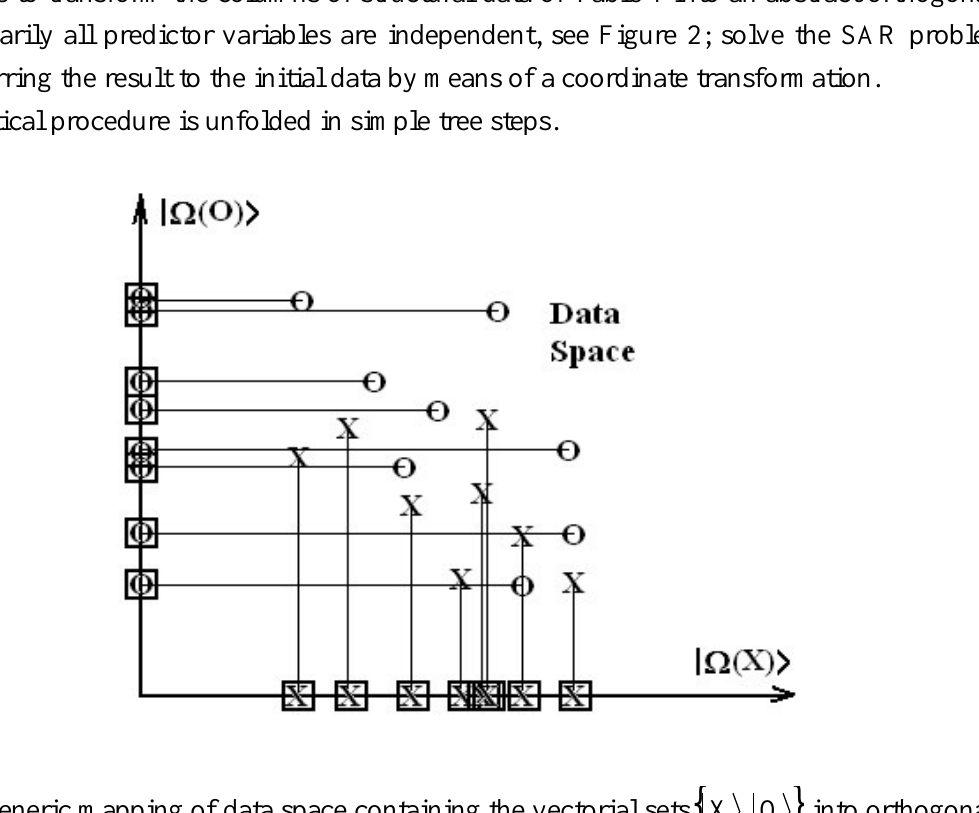
Figure 2. Generic mapping of data space containing the vectorial sets